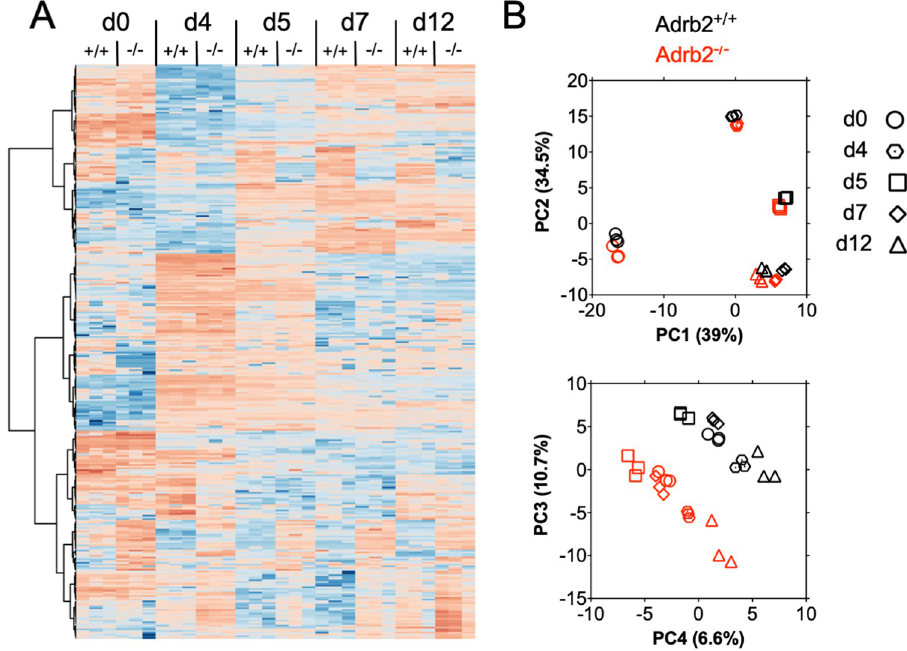
Fig 3. The ADRB2 regulates differential gene expression in CD8+ T cells during anti-viral responses in vivo. WT (CD90.1/1+) and Adrb2 -/- (CD90.1/2) CD8+ T cells were purified from recipient animals described in Fig 1A. RNA was isolated for RNASeq analysis from purified cells on day 0 and from infected hosts on days 4, 5, 7, and 12 post- infection. ( A ) EdgeR analysis identified all genes differentially expressed at any timepoint between WT and Adrb2 -/- cells. Gene expression values were used to perform 1-way hierarchical clustering, and data are displayed as a heat map. ( D ) Principal component analysis of differentially expressed genes between WT and Adrb2 -/- cells displayed as a function of each timepoint post-infection (PC1 vs PC2, top panel; PC3 vs PC4, bottom panel).